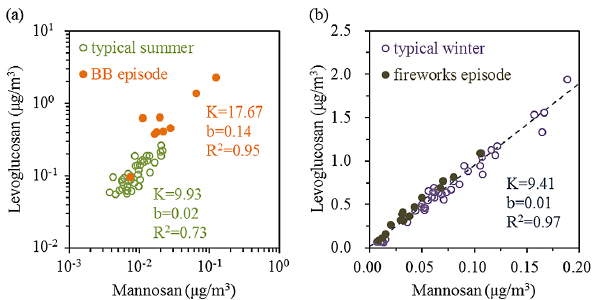
Fig. 4. The dependence of levoglucosan on mannosan during sum- mer (a) and winter (b) in Beijing. Linear regression results are shown with K as slope and b as intercept. In (a) , linear regression results of the BB episode (marked with orange font) and the typi- cal summer period (marked with green font) are shown separately, whereas the regression results in (b) are for the whole